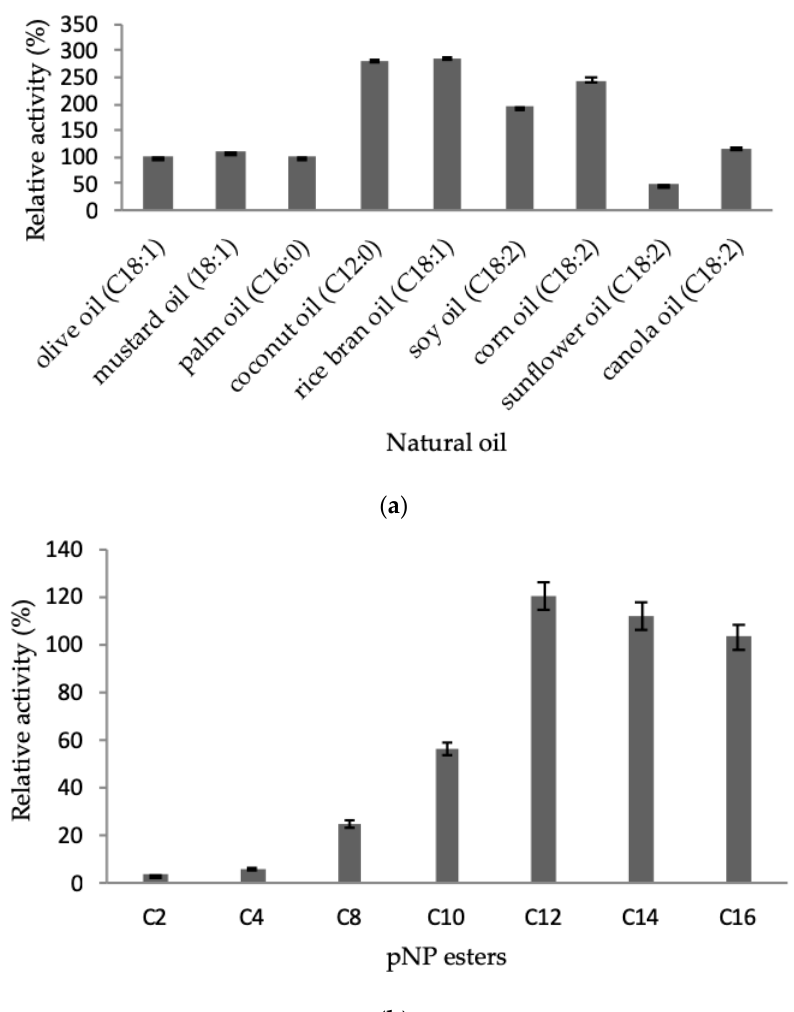
Figure 9. ( a ) Substrate specificity of purified LSK25 lipase toward various natural oils. ( b ) Substrate emulsion prepared with various synthetic esters. Incubation took place over 30 min at 25 °C and the assay was performed at 30 °C. Data shown are the means from triplicate measurements expressing activity relative to that with ( a ) olive oil and ( b ) p -nitrophenyl. Error bars represent standard deviations of means ( n = 3).